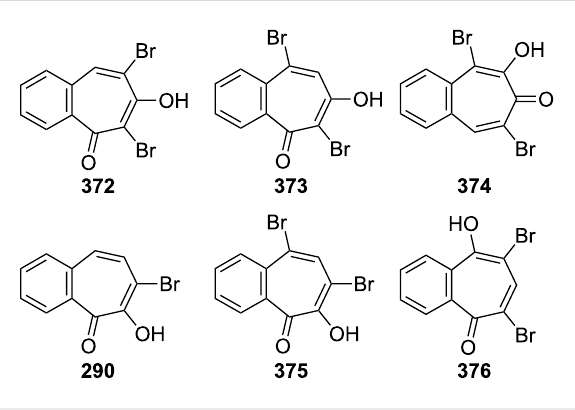
Figure 16: Bromobenzotropolones 372 – 376 and 290 prepared via bro- mination/dehydrobromination strategy. tropolone ( 382 ) was also obtained in 40% yield by the reaction between benzotropolone 241A and sodium iodide/sodium iodate in acetic acid (Scheme 70) [195].